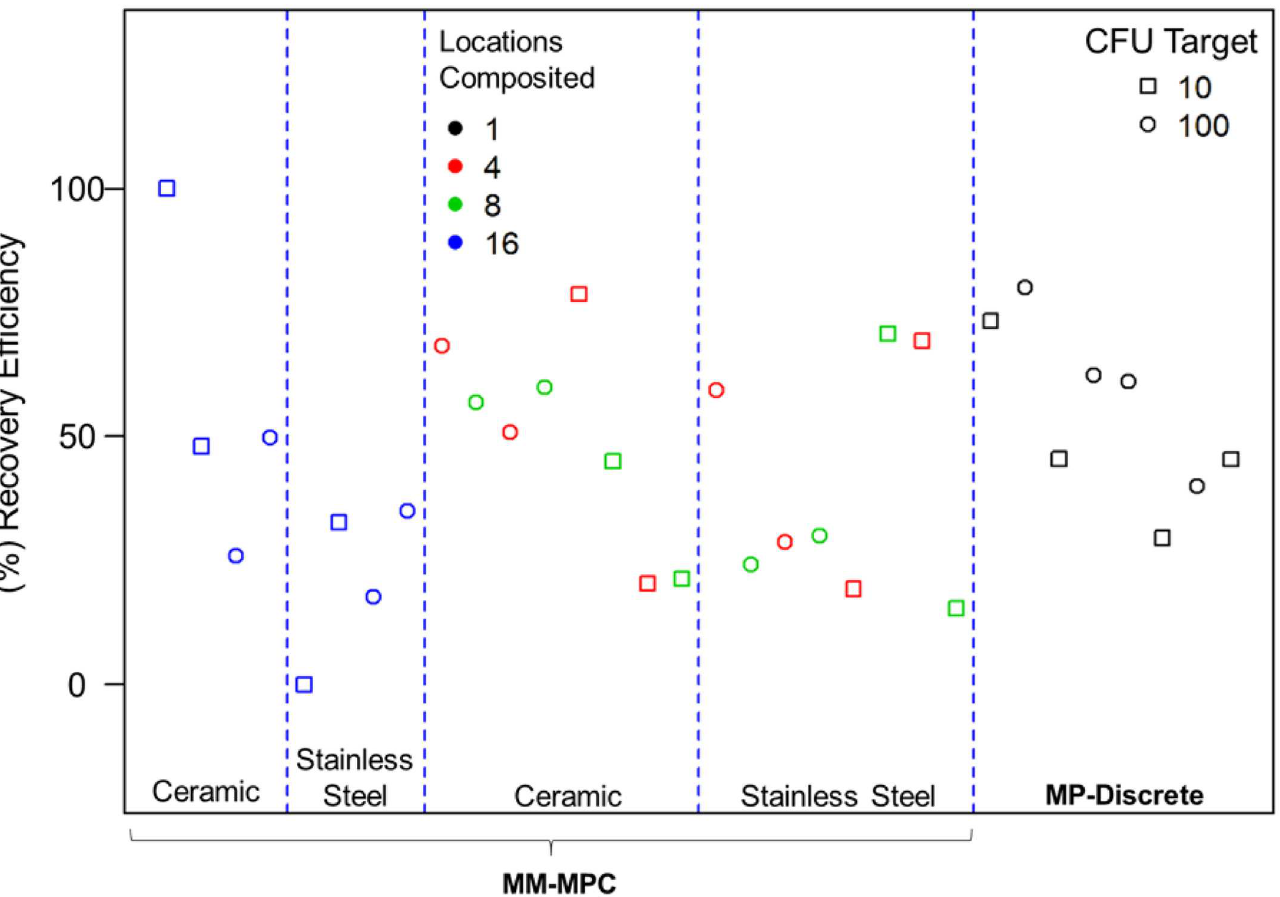
Fig 7. Increasing the number of locations composited from 8 to 16 does not reduceRE. The experiments wereconductedusing the MM-MPC methodology with 1, 4, 8, or 16 locationscomposited. The data for ceramicand stainlesssteel couponsare providedtogetherin the MP-Discrete